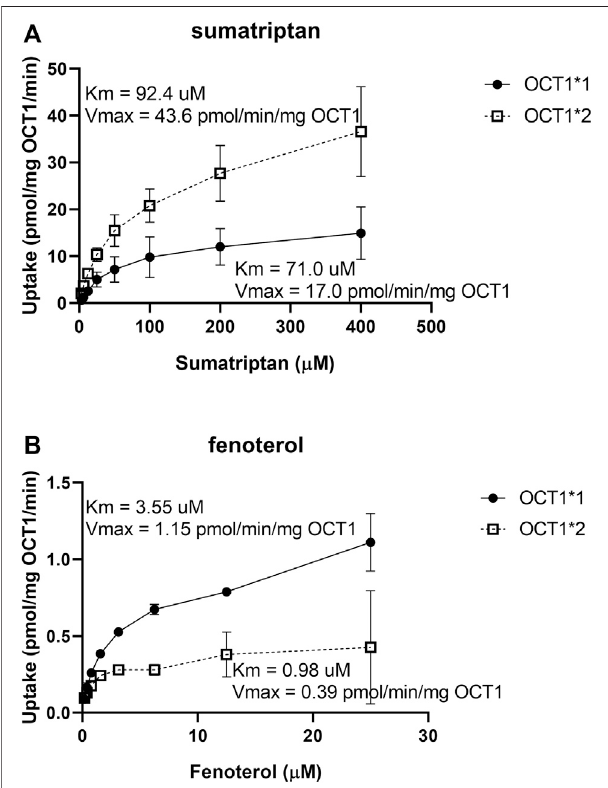
FIGURE 2 | Kinetics of sumatriptan (A) and fenoterol (B) in HEK cells expressing OCT1*1 or OCT1*2. Uptake was assessed over 1 min, in triplicate,atsubstrateconcentrationof3 µM.Dataarepresentedasmean ± SD.